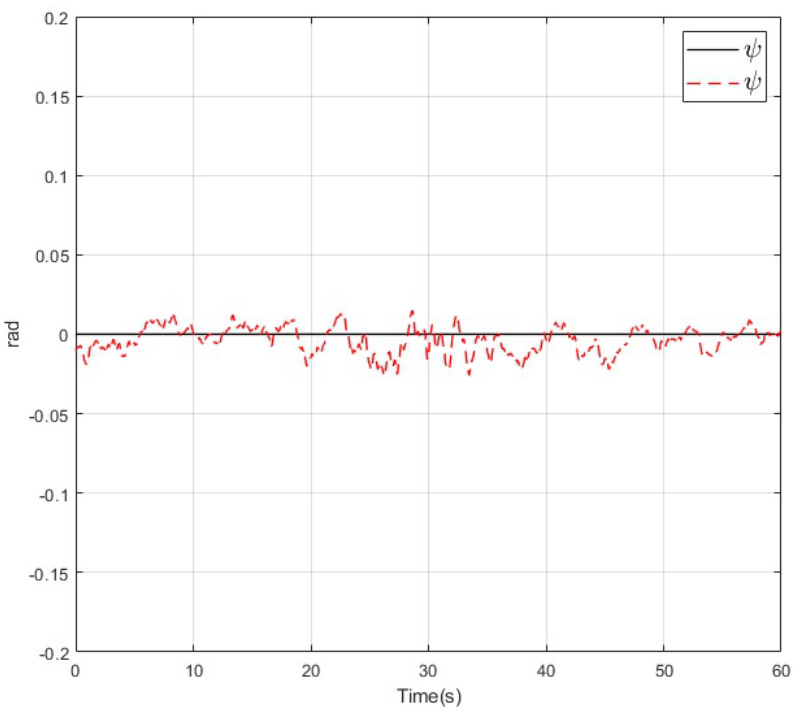
Figure 16. Yaw angle (dashed) and its reference (solid) during the real-time experiment.